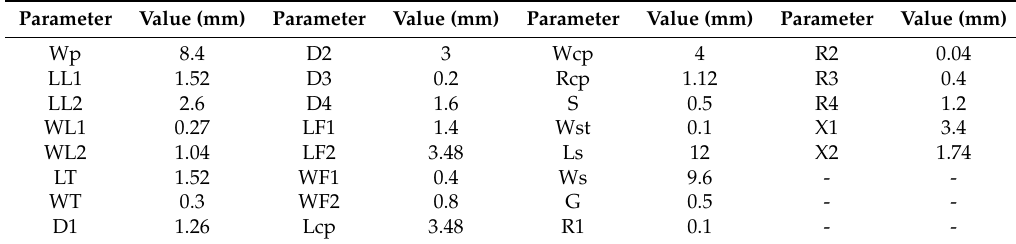
Figure 8. Simulated return loss for the proposed antenna with various radii of the ground structure ring (unit in mm). Table 3. Optimal geometrical parameters of the proposed monopole antenna.